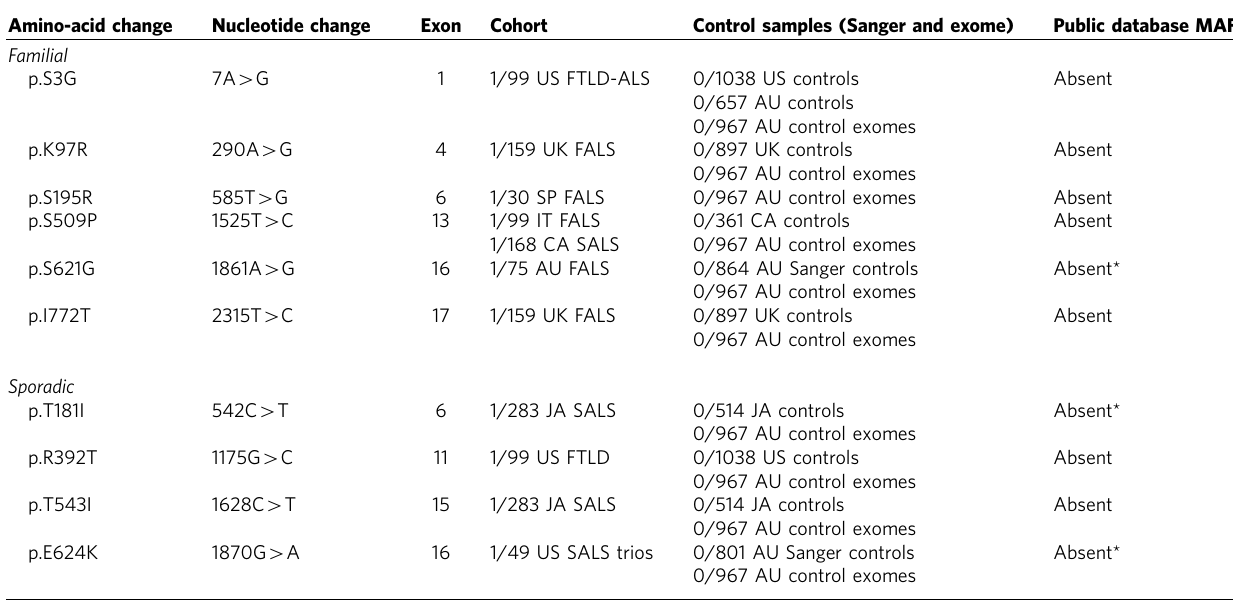
Figure 1 | CCNF mutations in ALS-FTD identified following genetic linkage analysis and exome sequencing. ( a ) Pedigree of family FALS10. All family members from whom DNA was available for genotyping are indicated by either wild type (WT) for CCNF , or by mutation in CCNF (‘S621G’). Individuals with ALS are represented by a black-filled symbol, individuals with FTD by a grey-filled symbol. Arrows indicate samples used for exome sequencing. ( b ) Sequence traces of WTand c.1861A 4 G mutation identified in family FALS10. ( c ) Diagrammatic representation of cyclin F protein and the location of novel mutations identified in this study. Cyclin F contains three functional modules within its protein structure. The F-box domain forms a ‘pseudocatalytic’ module, the two cyclin domains form the substrate recruitment module and the C terminus contains both a nuclear localization signal (NLS) and a PEST sequence (short stretch of amino acids enriched in proline, glutamic acid, serine and threonine) that form the regulatory module 16 . ( d ) Multiple sequence alignment of cyclin F across species showing evolutionary conservation of the substituted amino-acid residues (indicated by arrows). Sequences include NP_001752.2 (human), NP_001252844.1 (chimpanzee), NP_031660.3 (mouse), NP_001093944.1 (rat), NP_001092340.1 (cow), NP_001079901.1 (frog) and NP_996931.1 (zebrafish). Table 1 | ALS and/or FTD mutations in CCNF